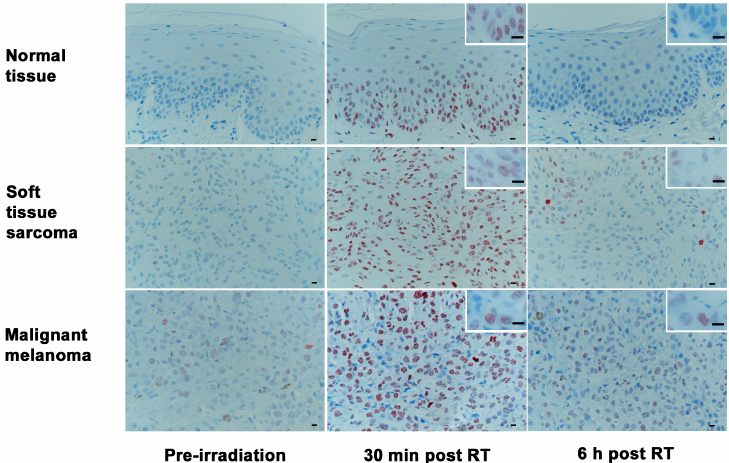
Figure 2. Staining for γ H2AX-foci before and after radiation treatment. Number of positive cells (%) ( A ) and number of γ H2AX-foci per positive cell ( B ) before and at indicated time-points after completion of the treatment. Mean values ± SD are shown.